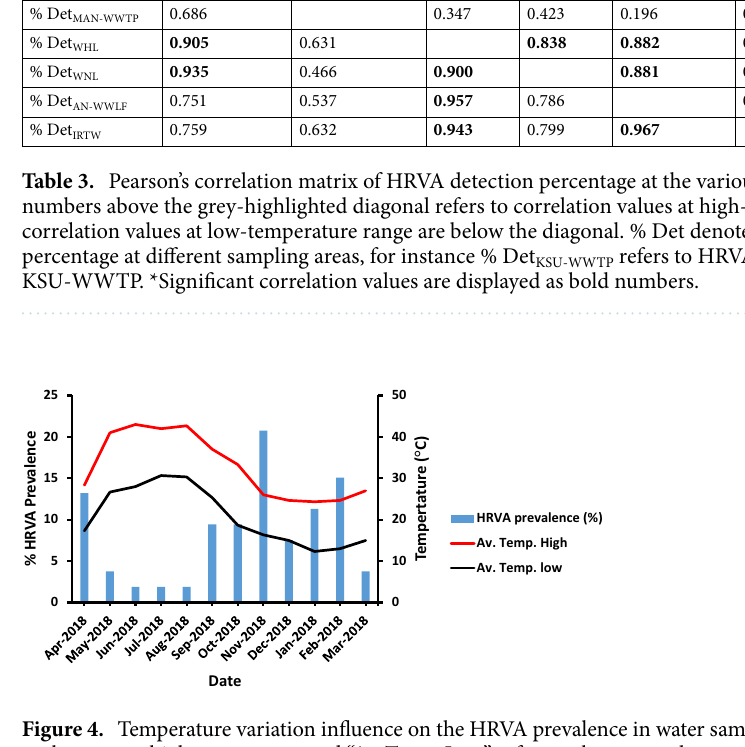
Figure 4. Temperature variation influence on the HRVA prevalence in water samples. “Av. Temp. High” refers to the average high temperature and “Av. Temp. Low” refers to the average low temperature.